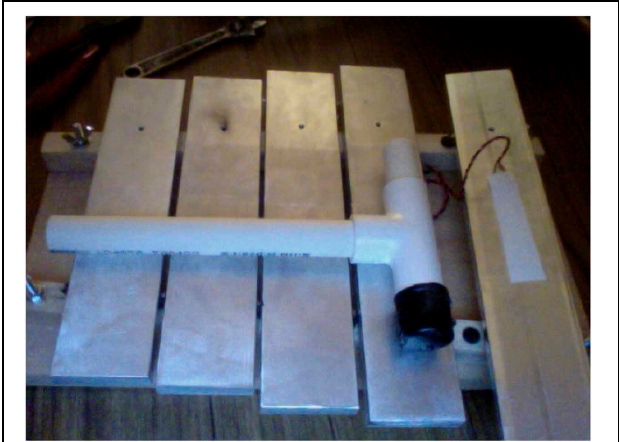
affixed to each key. This allows isolated recording of each